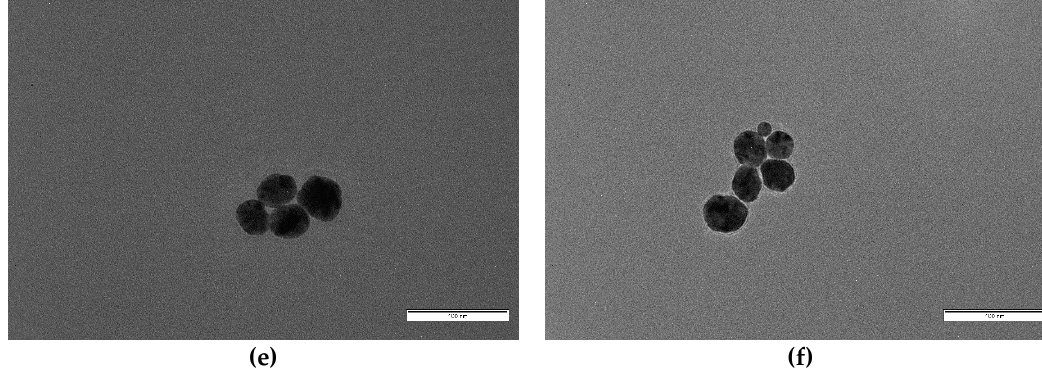
Figure 6. From up to down and left to right: TEM images of samples ( a ) S7, ( b ) S6, ( c ) S5, ( d ) S4, ( e ) S3, and ( f ) S0. All images were taken at the same magnification. Scale bar corresponds to 100 nm.